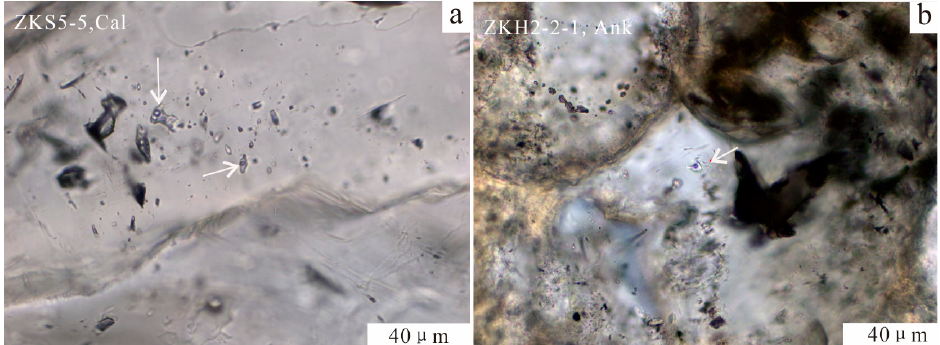
Figure 8. Two-phase (vapor and liquid) inclusions with a small size occur in the carbonate cement from the tight sandstone of the Lower member of Yaojia Formation. ( a ) Calcite bearing two-phase inclusions, ( b ) Ankerite bearing two-phase inclusions.